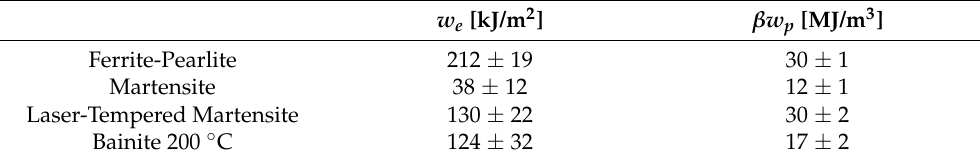
Table 4. Summary of essential work of fracture ( w e ) and non-essential plastic work ( β w p )